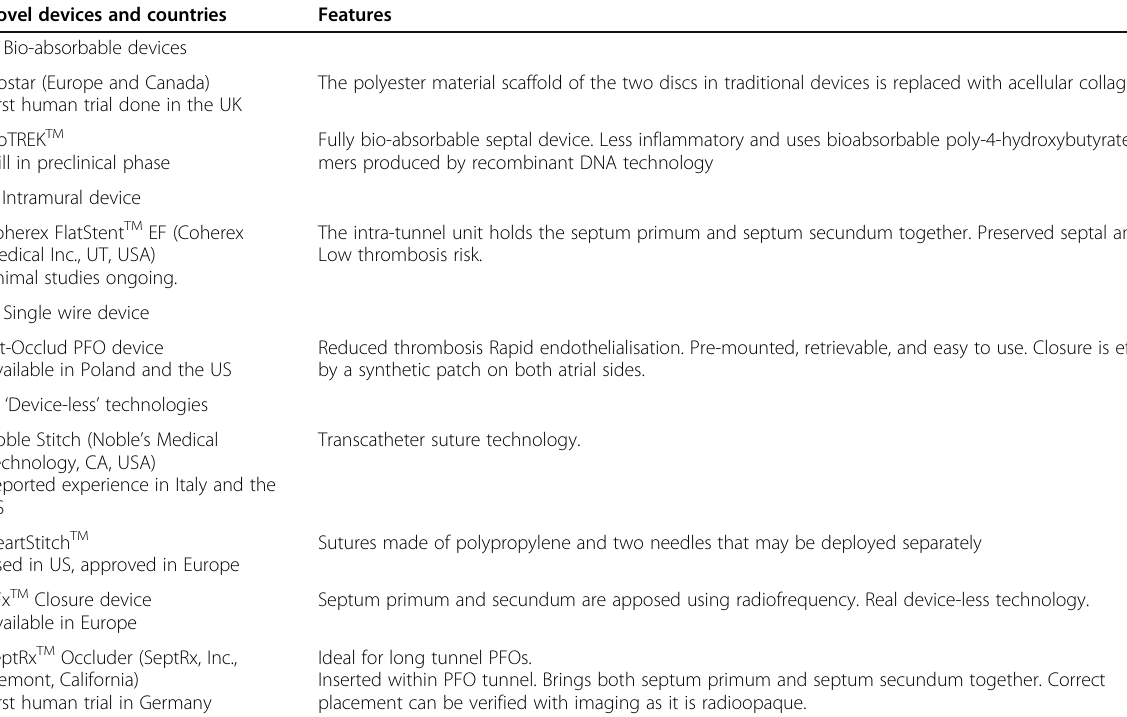
Table 3 Novel PFO closure technologies